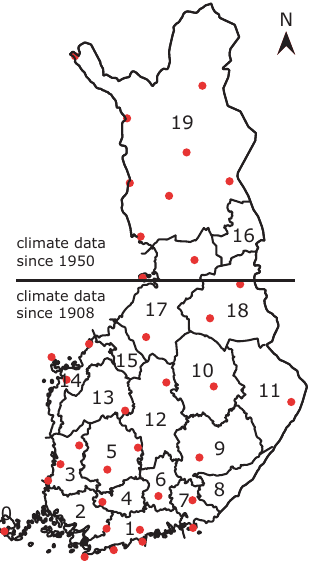
Fig. 1. Study regions are numbered from 1 to 20. Red dots mark the locations of the observation stations with FFI data. South of the horizontal line climate data start in 1908 while north of the line not until